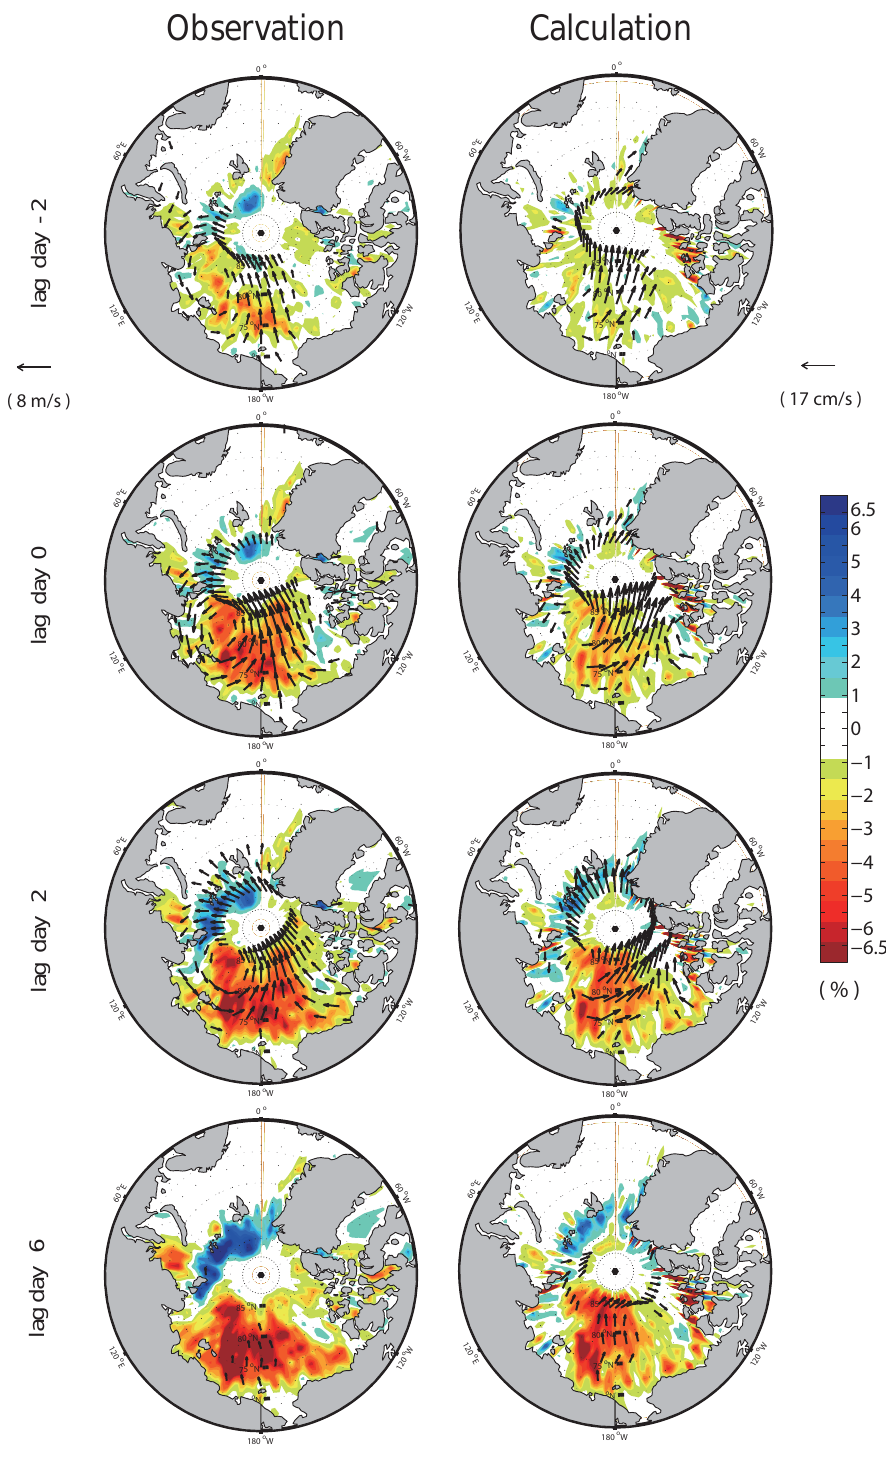
Figure 8. Composites of the anomalous sea ice concentration (%) calculated from NSIDC satellite observations (left column panel) and from our analytical model using ERA-Interim 10m wind velocity data (right column panels) for lag − 2 days (first row panels), 0 days (second row panels), 2 days (third row panels), and lag + 6 days (fourth row panels). See Sect. 5 for a full description of this calculation. Vectors indicate the anomalous 10m winds from reanalysis (ms − 1 ; left column panels) and calculated sea ice velocity (cms − 1 ; right column panels). For the anomalous 10m winds (left column panels) and sea ice velocity (right column panels), only vectors stronger than 1.5ms − 1 and 3.0cms − 1 are plotted,